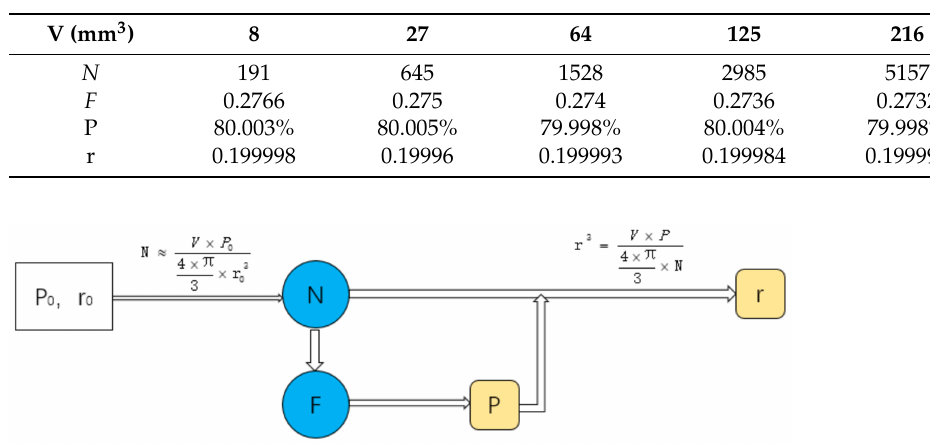
Table 3. To achieve target P 0 and target r 0 , adjust actual F to design structures with actual P and r.